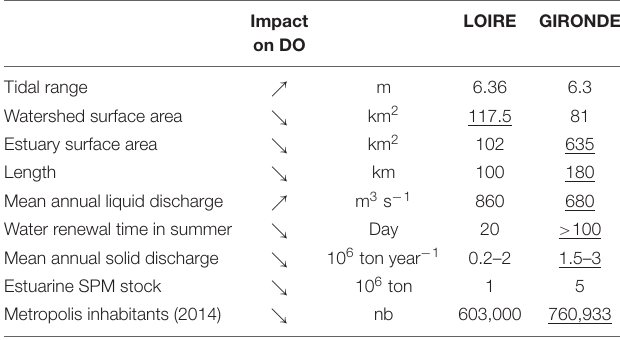
Underlined values highlight the most unfavorable case between the Loire and the Gironde estuaries. TABLE 2 | Pearson’s correlation coefficients between daily average DO (mg L − 1 ) and parameters, i.e., temperature, discharge and turbidity for the complete time-series (all seasons) and for the period from May to